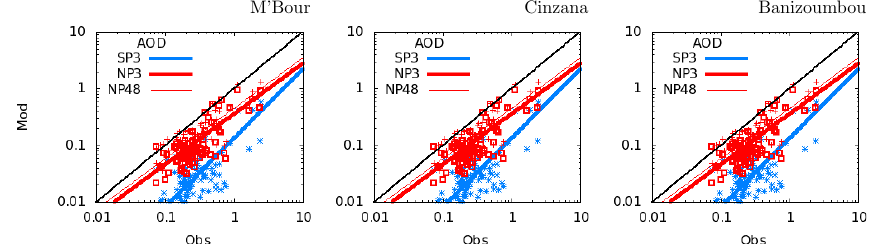
Figure 6. Scatter plots of the model vs. observed AOD at M’bour, Cinzana and Banizoumbou for simulations SP3 (blue), NP3 (thick red line and squares) and NP48 (thin red line and crosses) computed at daily frequency.